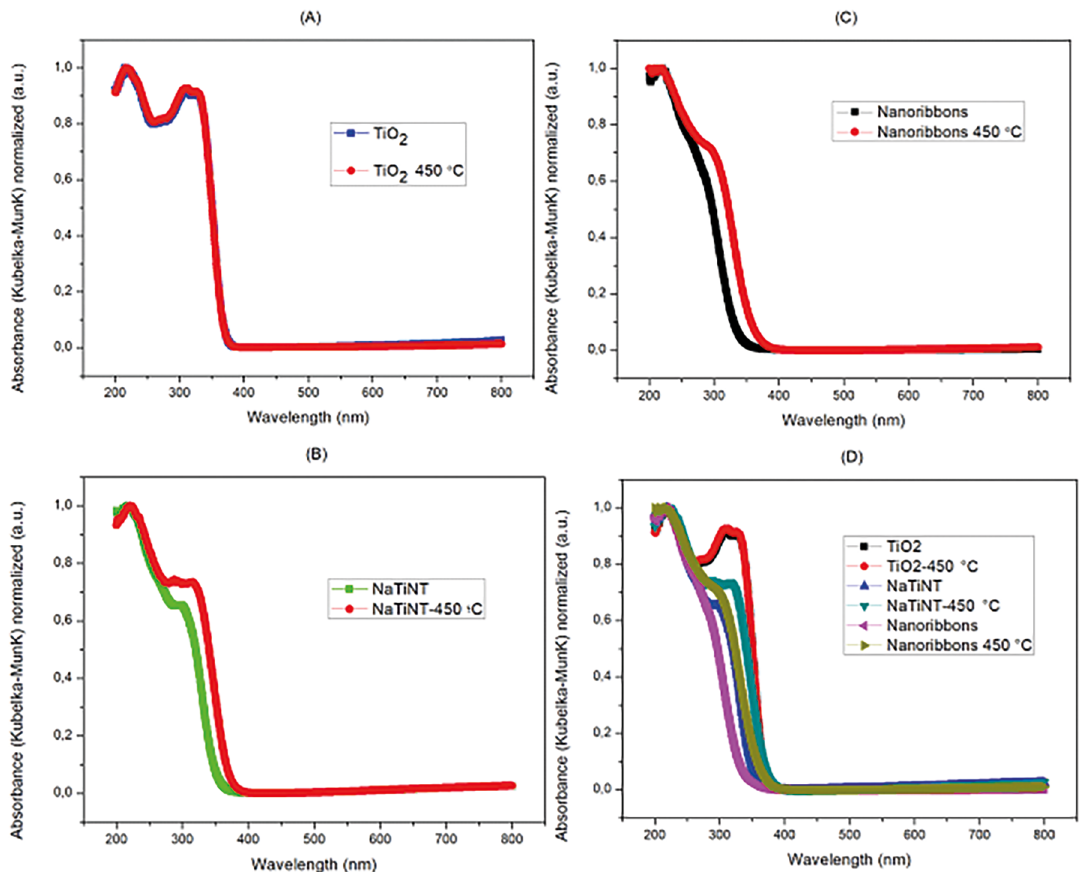
; (B) NaTiNT; (C) Nanoribbons and (D) overlap of the spectrums before and after the heat treatment. Figure 3. Absorbance of the films: (A) TiO 2